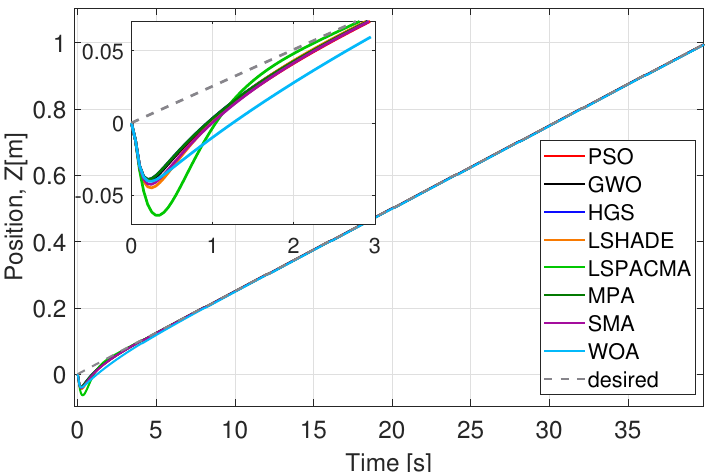
Figure 8. Comparison of tracking performance in Z–axis of the different algorithms evaluating parameters obtained with 20